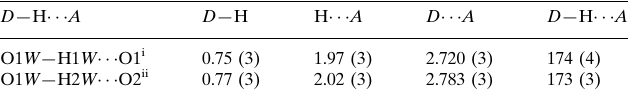
Hydrogen-bond geometry (A˚ , (cid:2)